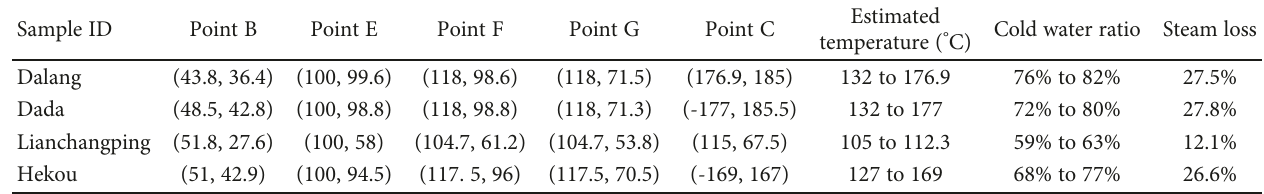
Figure 5: Dissolved silica-enthalpy mixing model graph assuming that steam separated at 100 ° C (a vertical dotted line from the enthalpy value of 418.68 J/g marked as water boiling point) from the thermal groundwater component before mixing [6]. Point A is the local cold water (the Hudie cold spring which is close to local meteoric water). Point B represents the hot spring water. Coordinates of the points refer to Table 5. Table 5: Calculated underground temperatures from the thermal groundwater using quartz steam loss geothermometers [5] and dissolved silica-enthalpy graph considering the maximum steam loss